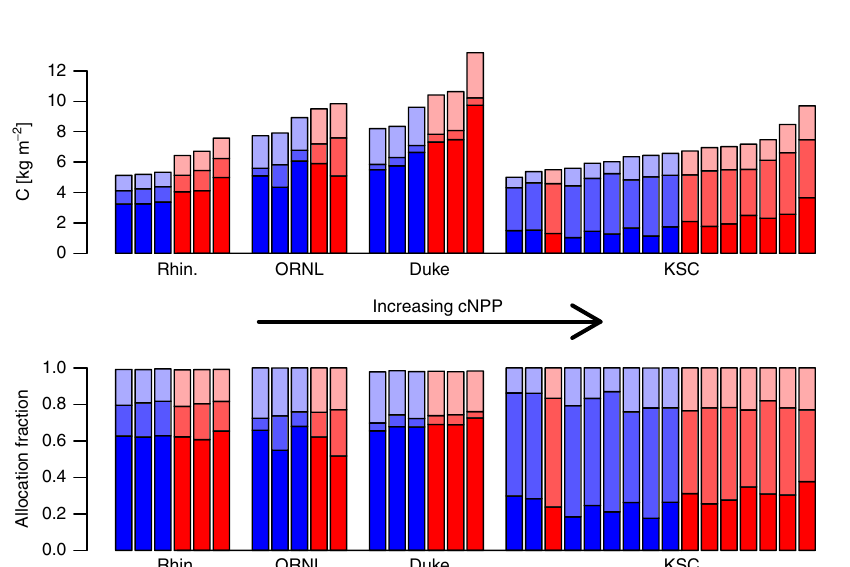
Fig. 3 Allocation in absolute terms and fractions in each sample plot. a Allocation in absolute terms, b allocation in fractions. Ambient CO 2 plots in blue, elevated in red; darkest shades, wood allocation; medium shades, root allocation; and lightest shades, leaf allocation. Within each site, plots are arranged from left to right in order of ascending cumulative